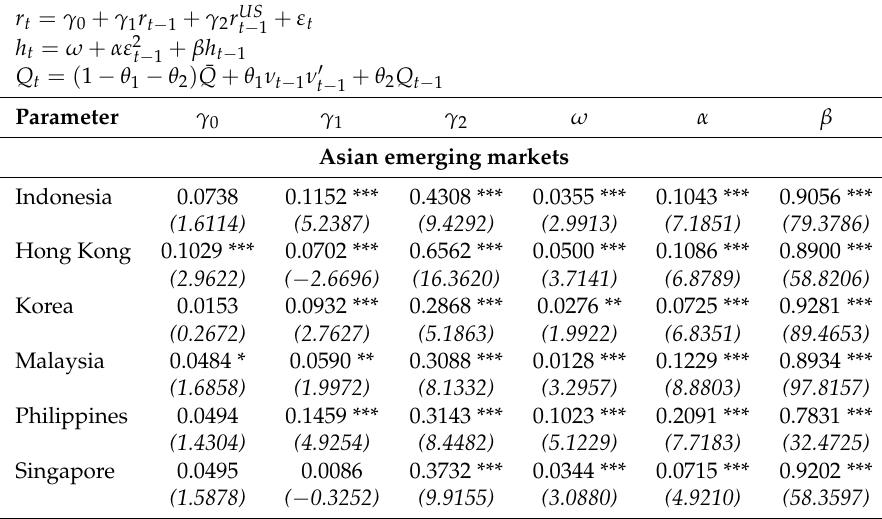
Table 6. Estimation of DCC-GARCH model for the Asian “flu”